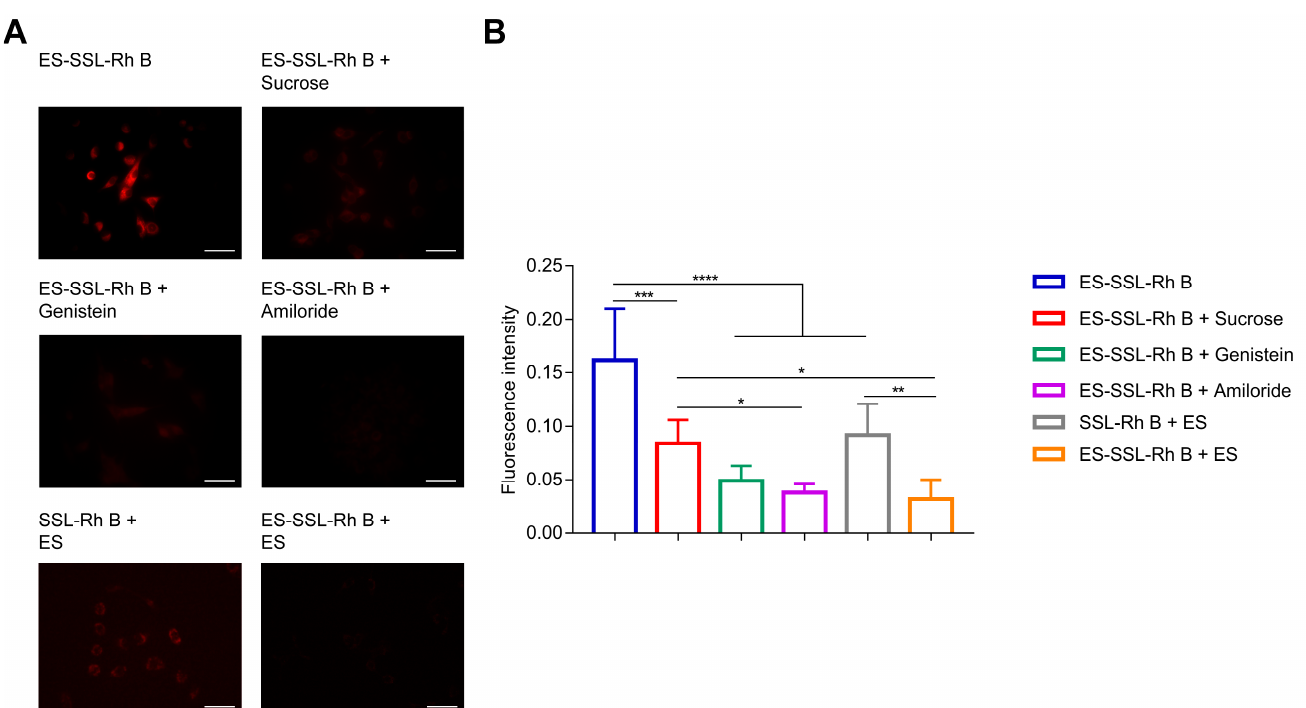
Figure 7. In vitro endocytosis mechanism study. ( A ) Cellular uptake of ES-SSL-Rh B in A549 cells determined using fluorescence microscopy after pretreating with endocytosis inhibitors and ES. Scale bar: 50 μ m. Original magnification: ×200. ( B ) The result of fluorescence intensity quantified using Image J, * p < 0.05, ** p < 0.01, *** p < 0.001, **** p < 0.0001.